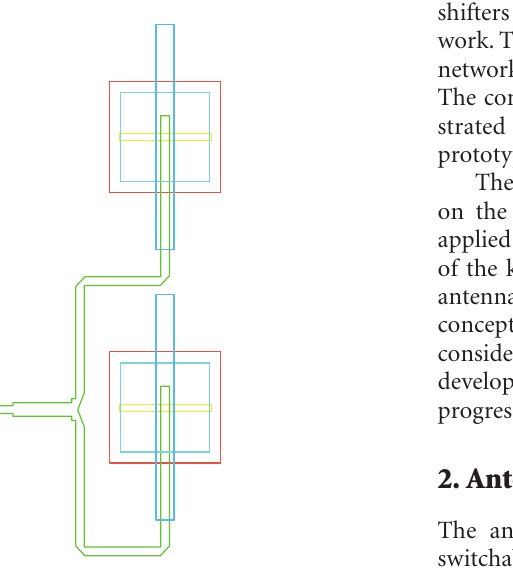
Figure 3: Vertical subarray topology.